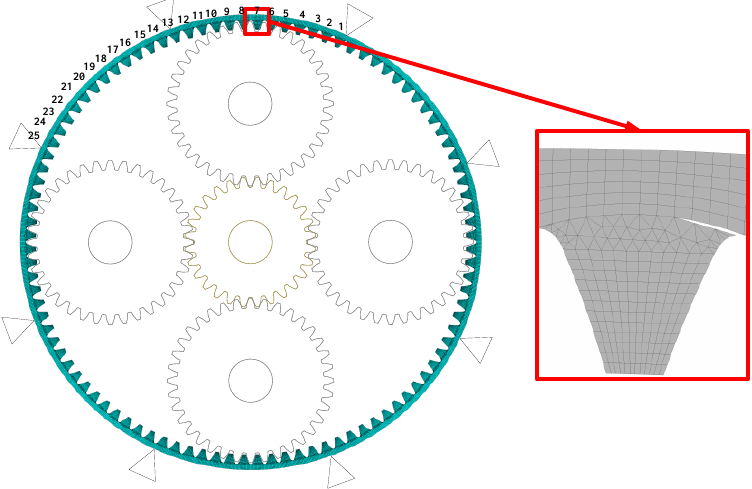
Figure 18. Diagram of tooth root crack model of the inner ring.